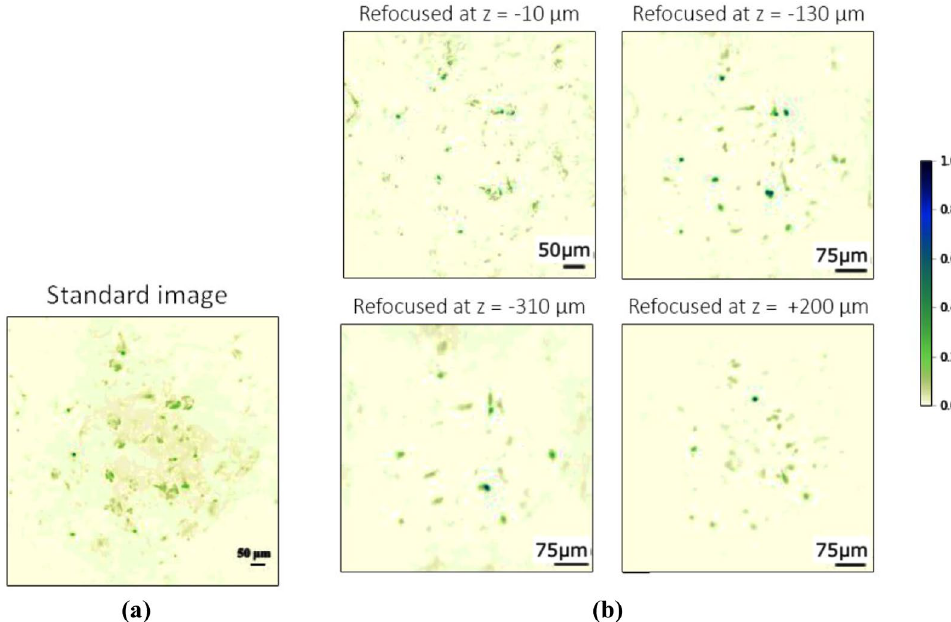
Figure 4. First-order image of a thick biomedical phantom ( a ) acquired at f − f O = 0 µ m , and refocused CLM images of four distinct planes inside the same sample ( b ); the specific value of z = f − f O is reported on top of each image. All images have been obtained from the same data, using N = 5000 frames. The technique used to optimize the correlation function in this case is described in the “Materials and methods” section.